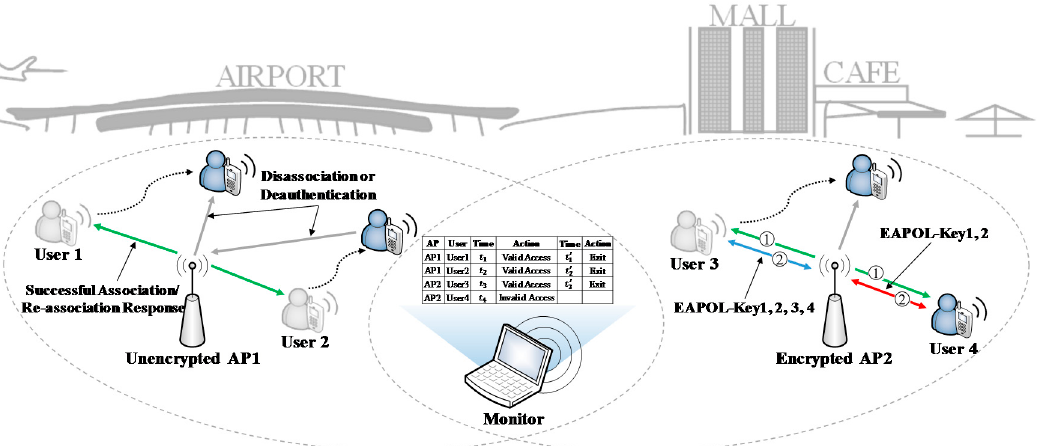
Figure 1. Description of formulating people’s access behaviors in Wi-Fi networks.